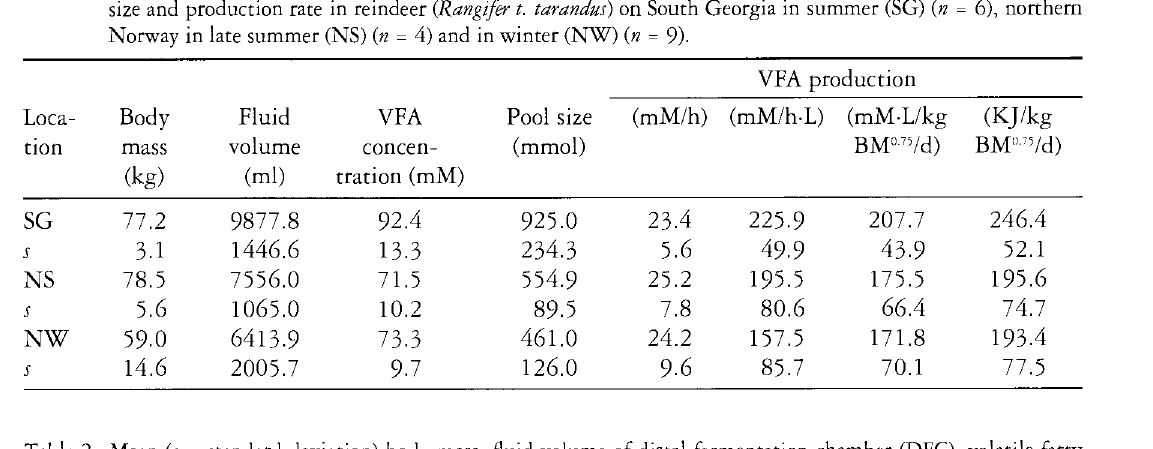
Table 1. Mean (s = standard deviation) body mass, ruminal fluid volume, volatile fatty acid (VFA) concentrarion pool size and production rate in reindeer (Rangifer t. tarandus) on South Georgia in summer (SG) (n = 6), northern Norway in late summer (NS) (» = 4) and in winter (NW) (n - 9).